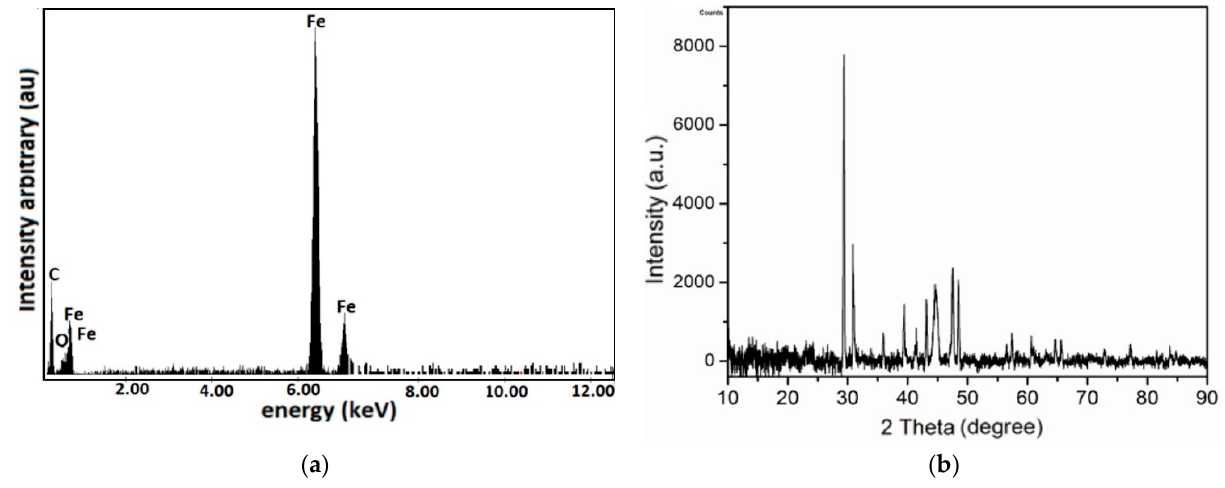
Figure 6. The MPS viewed under a digital microscope: ( a ) In the absence of the magnetic field; ( b ) in the presence of the magnetic field ( H ≈ 40kA m⁄ ).